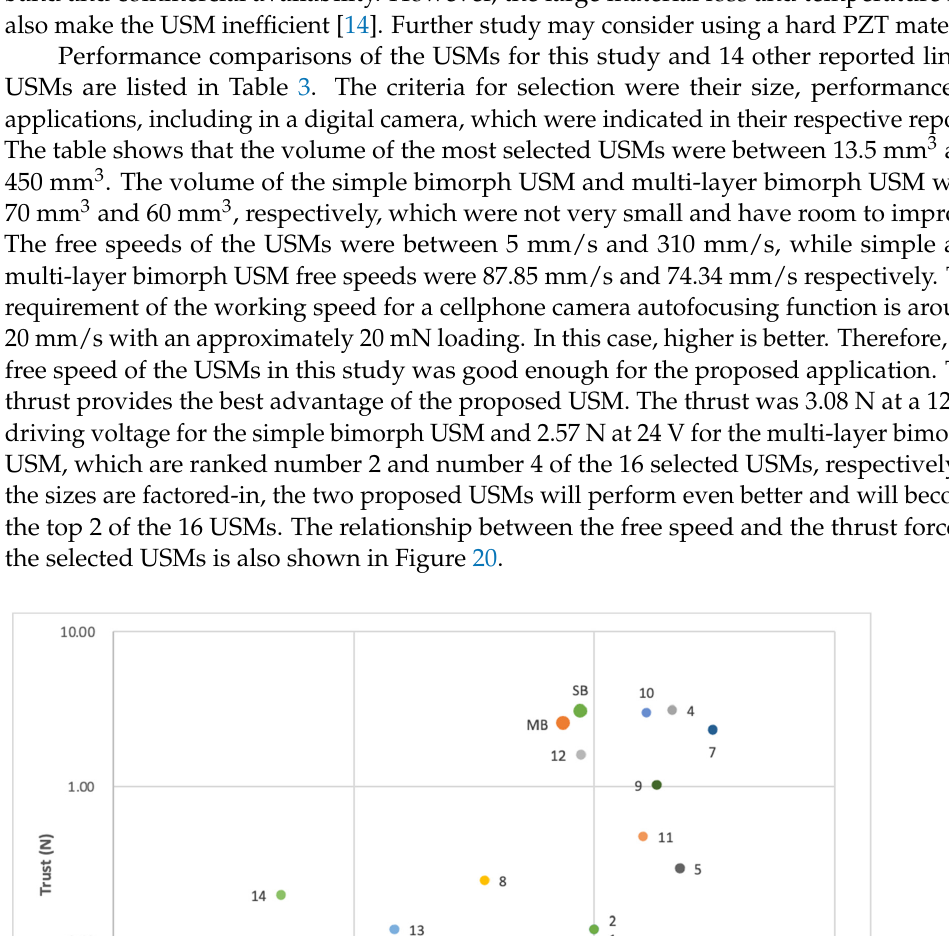
Table 3. Comparisons of the USMs.